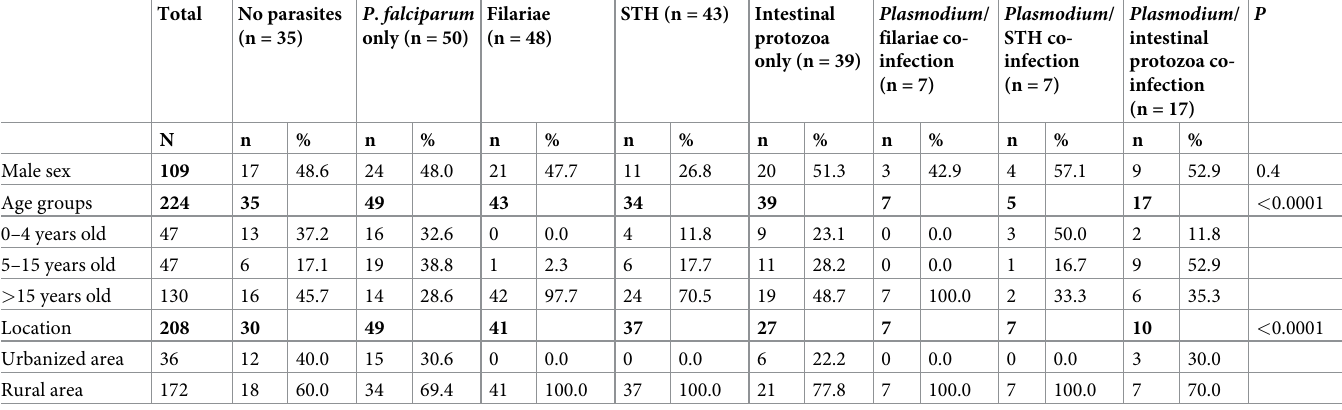
p values were obtained using Fisher’s exact